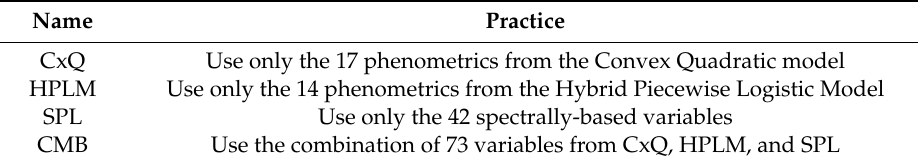
Table 4. Input variables for Random Forest Classifier (RFC)